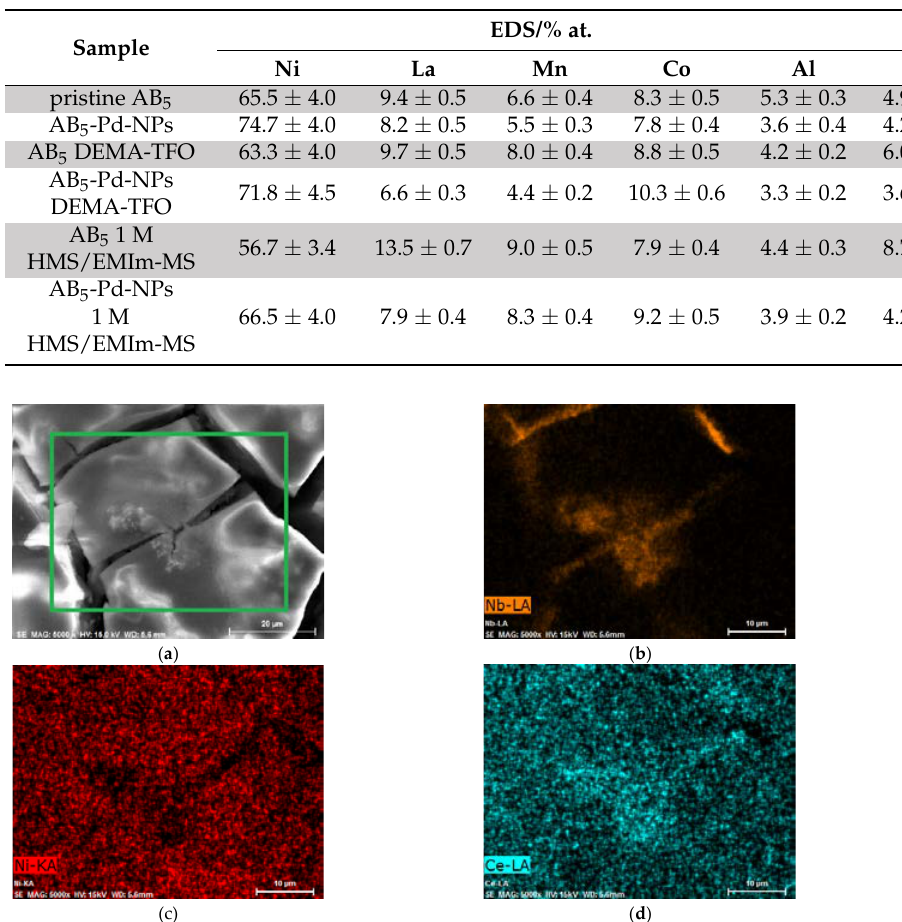
Figure 3. AB 5 alloy electrode after electrochemical treatment in 1 M HMS/EMIm-MS ( a ) SEM image – EDS mapping for the area marked with a green rectangle; EDS map of ( b ) Nb – orange, ( c ) Ni – red, and ( d ) Ce – cyan. EDS mapping of other elements is presented in Figure S1.